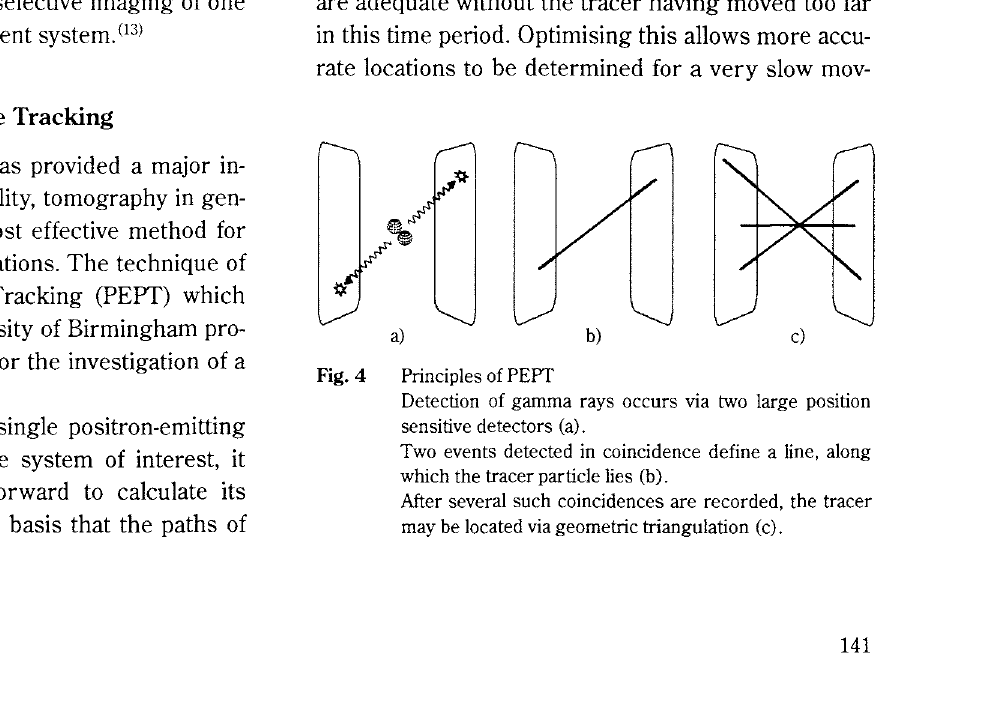
Fig. 4 Principles of PEPT Detection of gamma rays occurs via two large position sensitive detectors (a). Two events detected in coincidence define a line, along which the tracer particle lies (b). After several such coincidences are recorded, the tracer may be located via geometric triangulation